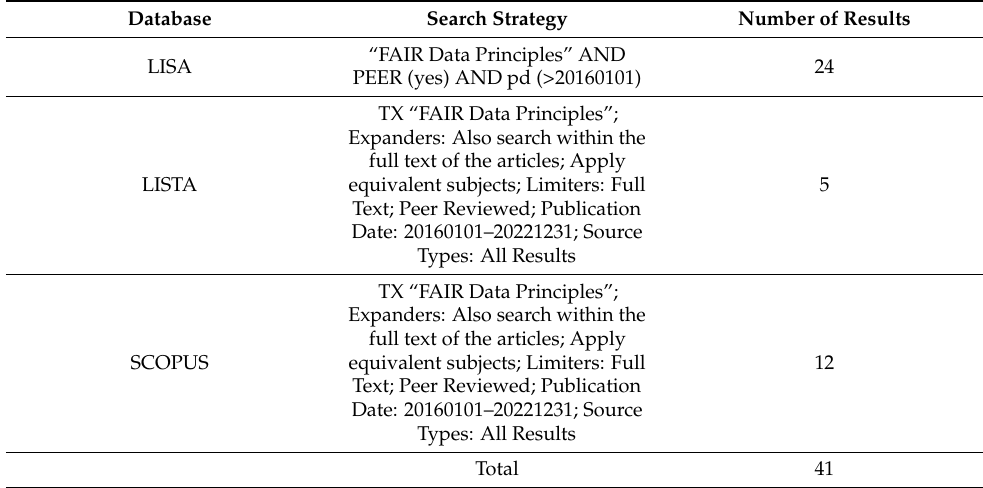
Table 1 identifies the following search strategies. Table 1. Databases, search strategies, and number of